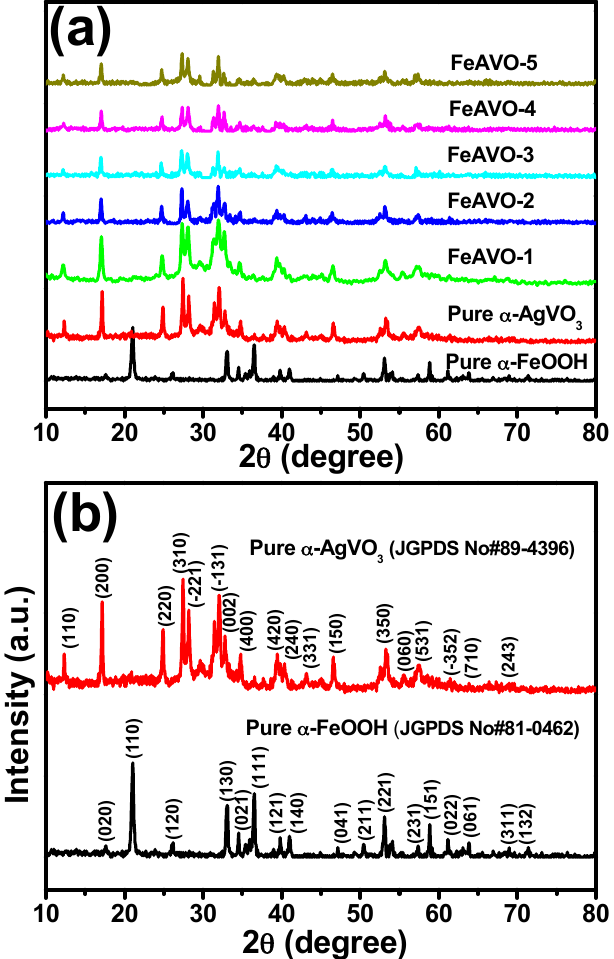
Figure 2. ( a ) X-ray diffraction (XRD) patterns of pure α -FeOOH, pure AgVO 3 and different α -FeOOH/ α -AgVO 3 nanocomposite photocatalysts and ( b ) XRD patterns of pure α -FeOOH and pure α -AgVO 3 with their corresponding (hkl) values.